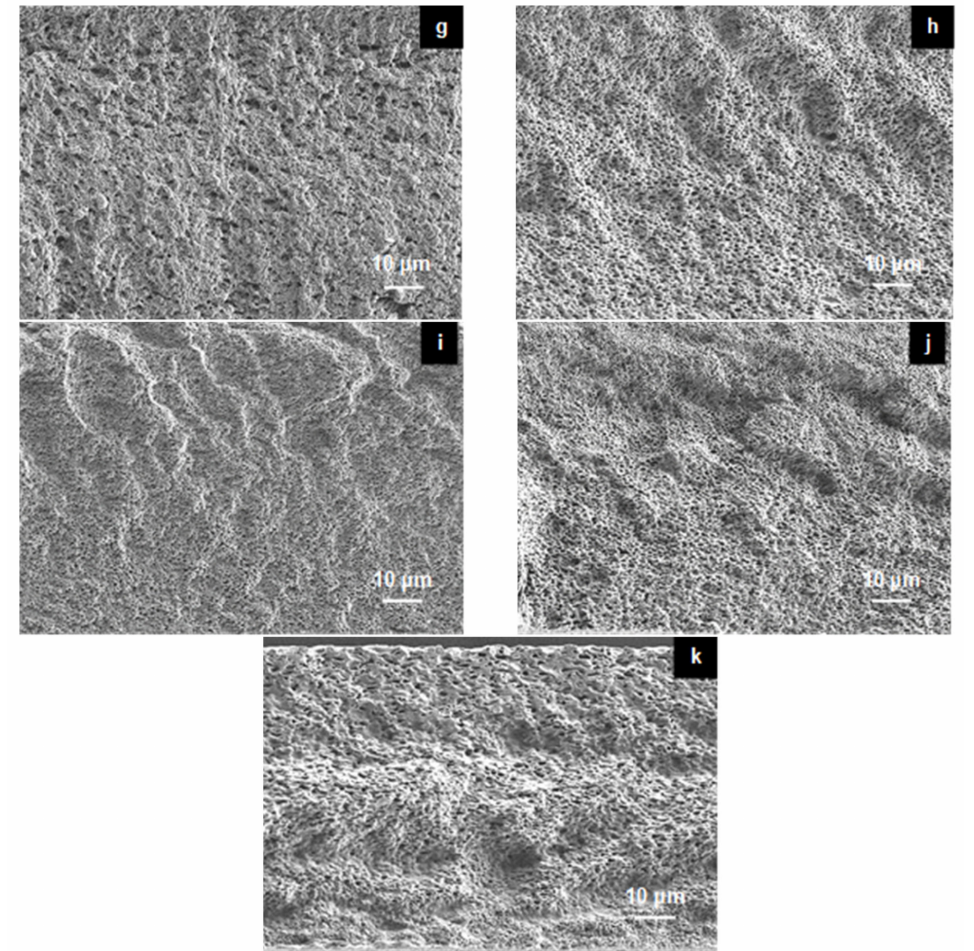
Figure 3. FESEM micrographs of the cross-sectional views for the ( a ) NMPC membrane, ( b ) PVA membrane, ( c ) NMPC/PVA-30 membrane, ( d ) NMPC/PVA-35 membrane, ( e ) NMPC/PVA-40 mem- brane, ( f ) NMPC/PVA-45 membrane, ( g ) NMPC/PVA-50 membrane, ( h ) NMPC/PVA-55 membrane, ( i ) NMPC/PVA-60 membrane, ( j ) NMPC/PVA-65 membrane, and ( k ) NMPC/PVA-70